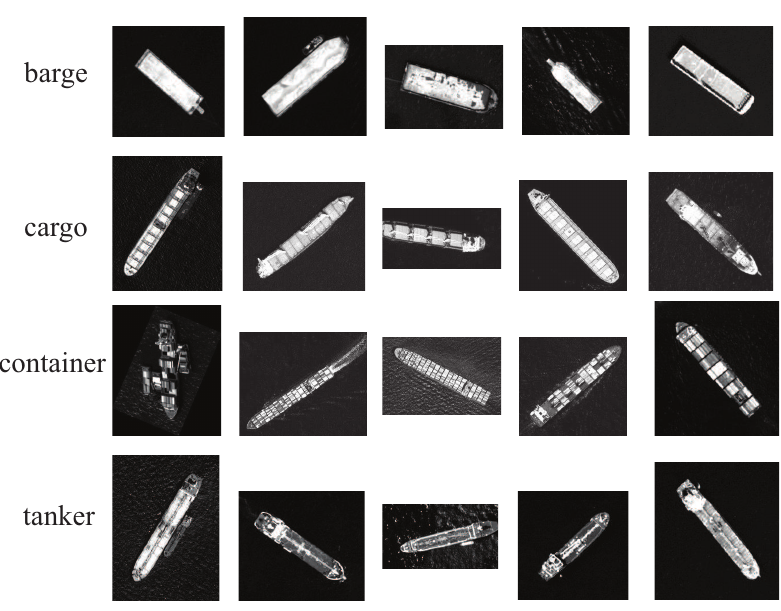
Figure 6. Illustration of the BCCT200-resize data.